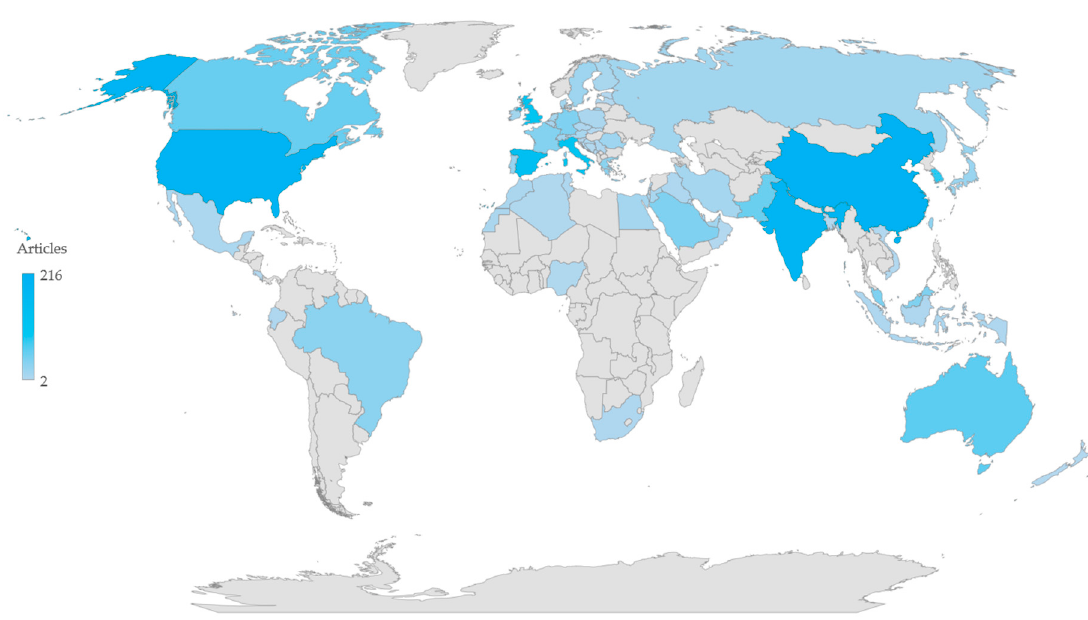
Figure 7. Scientific production by countries (2011–2019).